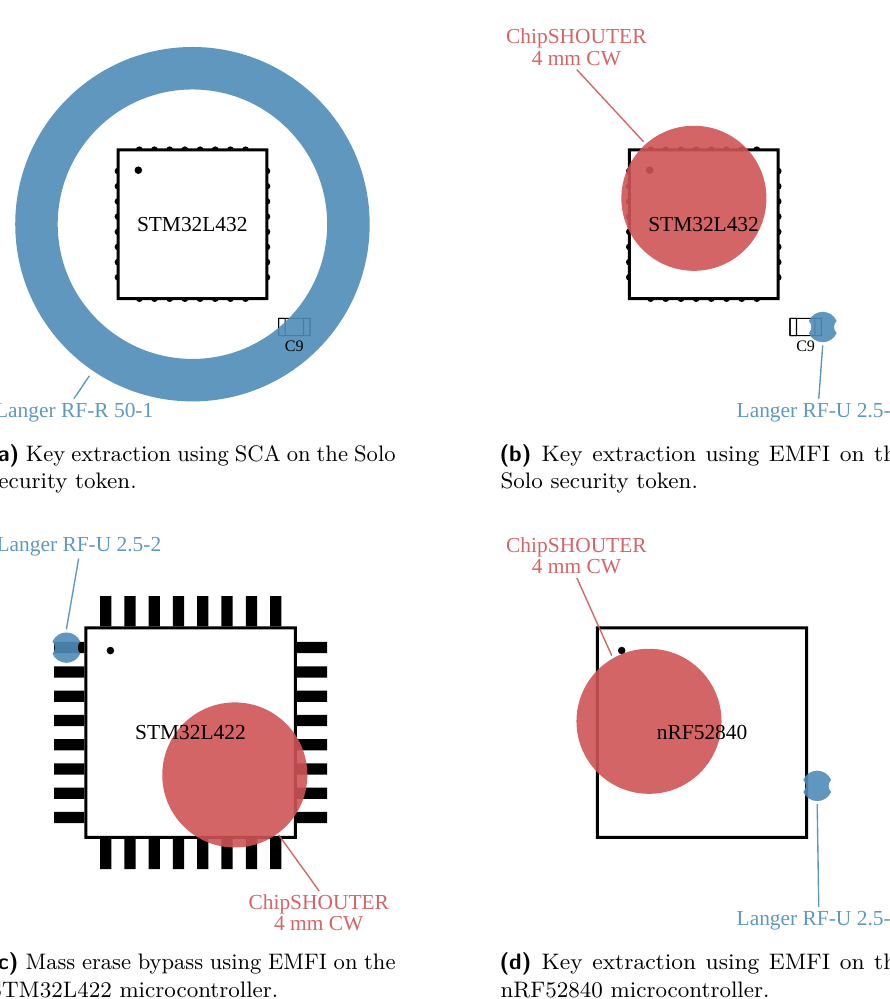
Figure 10: Schematic top view of the examined devices. Blue highlights the position of the EM probe for the side-channel analysis. Red highlights the position of the EM injection coil for the fault injection